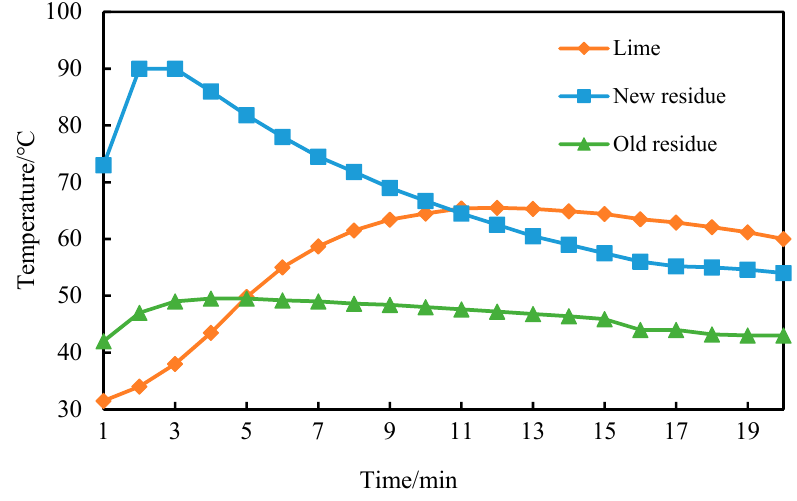
Figure 7. Exothermic characteristic curve of new residue, old residue, and lime.